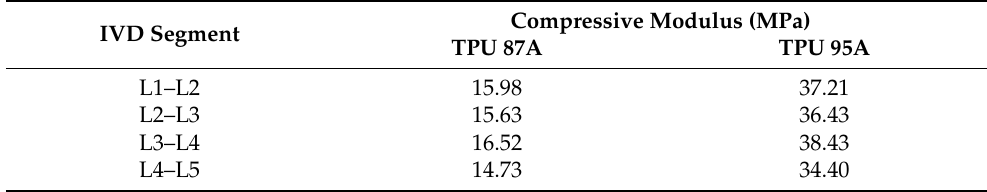
Table 1. Compressive moduli of ABC-MTDR for each IVD segment based on the Voight composite model calculation.